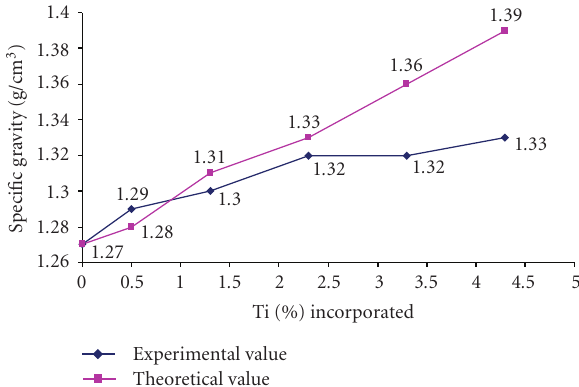
Figure 6: Specific gravity of the polymer increases with increase in titanium content.